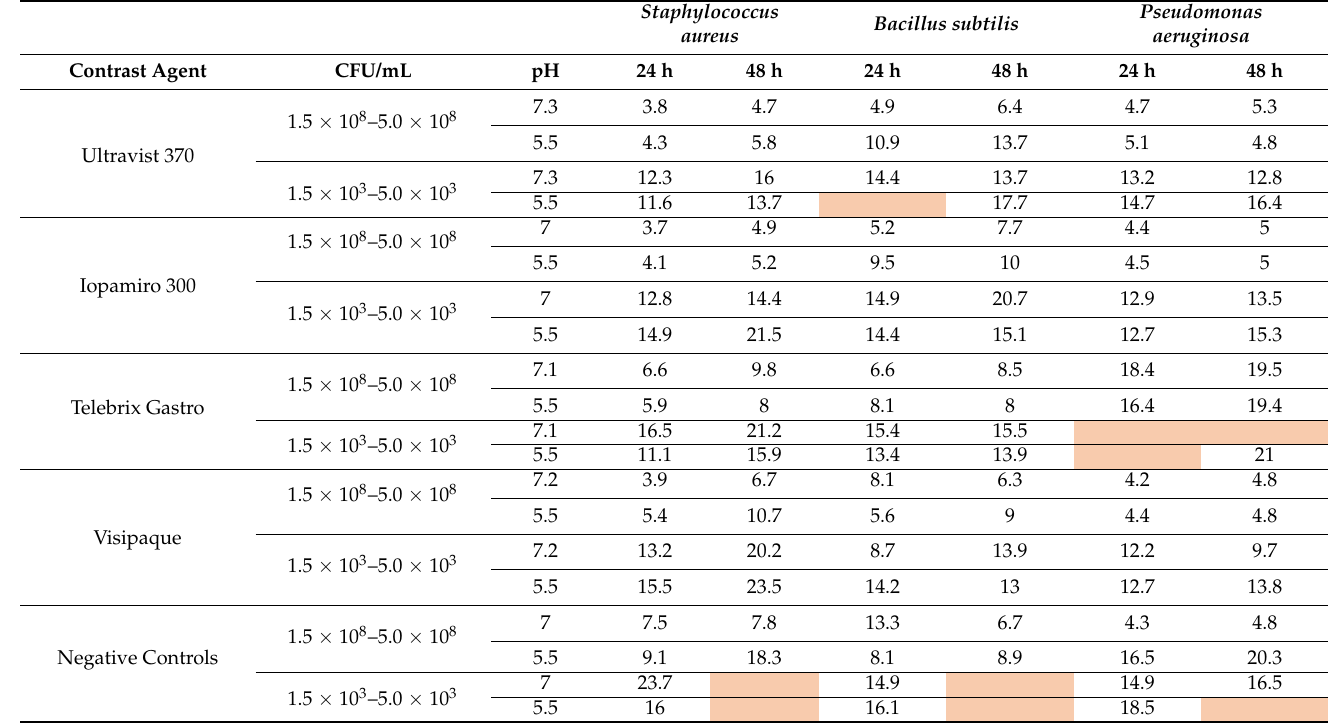
Table 1. Indication of the time interval until the growth of the bacteria was detected. Missing growth is highlighted in red